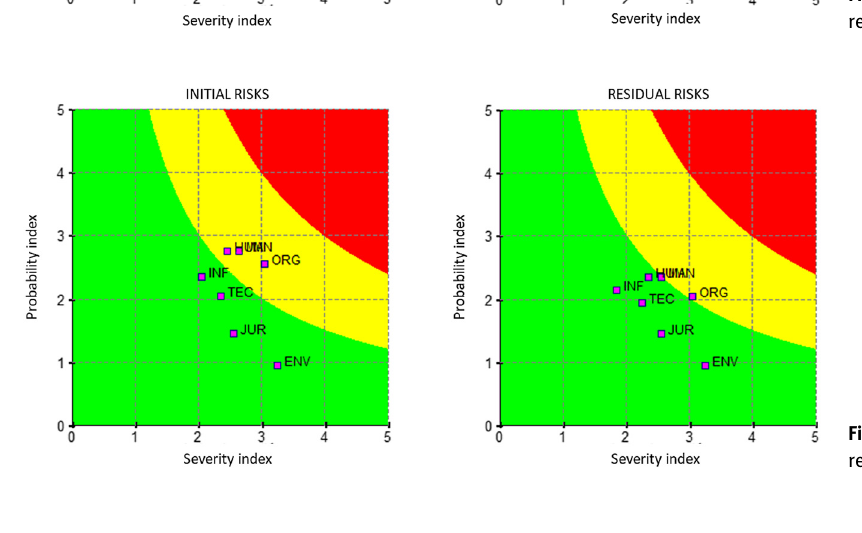
Figure 3: Farmer ’ s diagram of initial and residual risks by phase for PRA1.